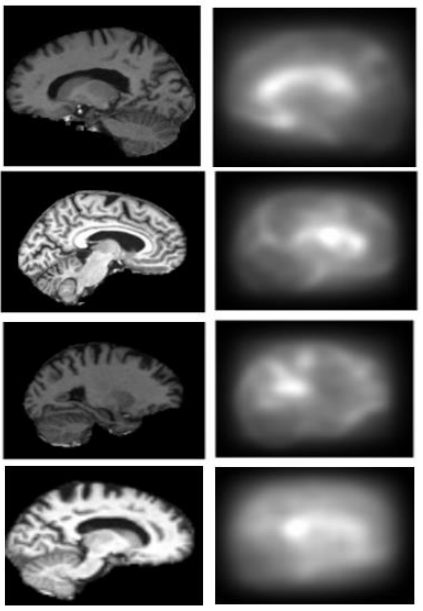
Figure 7. Saliency maps of normal subjects ’ MRI images.